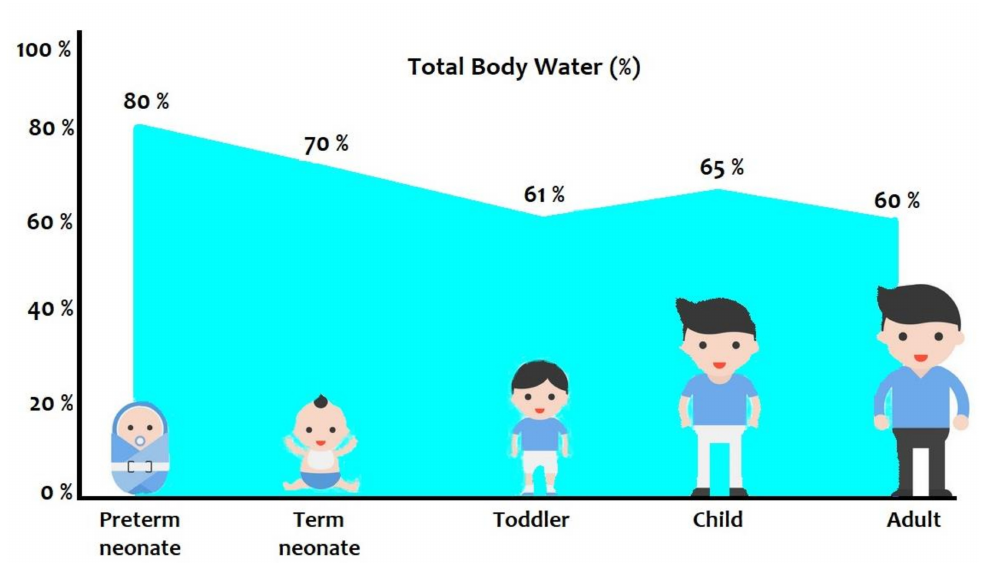
Figure 1. Body composition (total body water) and growth. Modified from Rodieux et al.